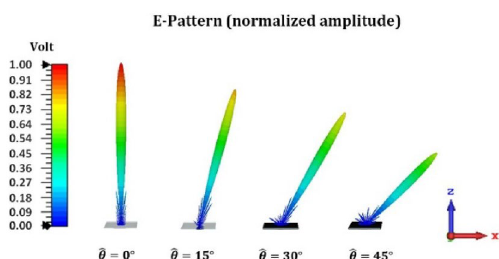
Figure 12. 3D E-pattern of pencil-beam for different radiation angles ( ˆ θ = 0 ◦ , 15 ◦ , 30 ◦ , 45 ◦ & ˆ φ = 0 ◦ ).The dimension of cell-cluster is 9*9